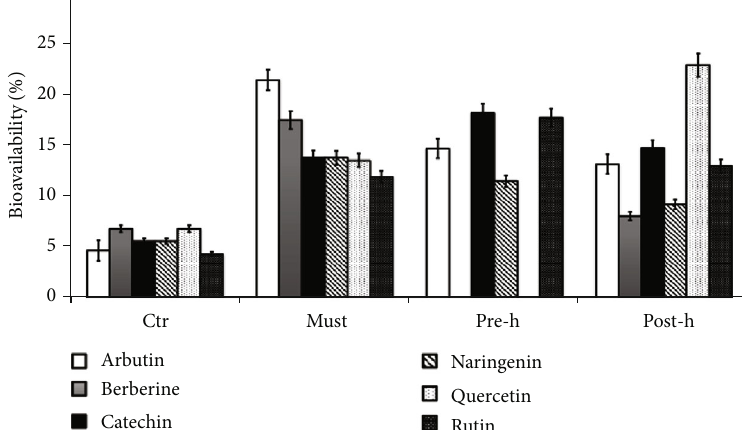
Figure 5: Bioavailability of beer polyphenols in the Caco-2 cell model. Cells were treated with beer fractions: must (must), prehopping solution (pre-h), and posthopping solution (post-h), for 4 h. The bioavailability of individual polyphenols in beer extracts is expressed as % of polyphenols which exceeds the apical compartment and passes into the basolateral compartment and collected for HPLC